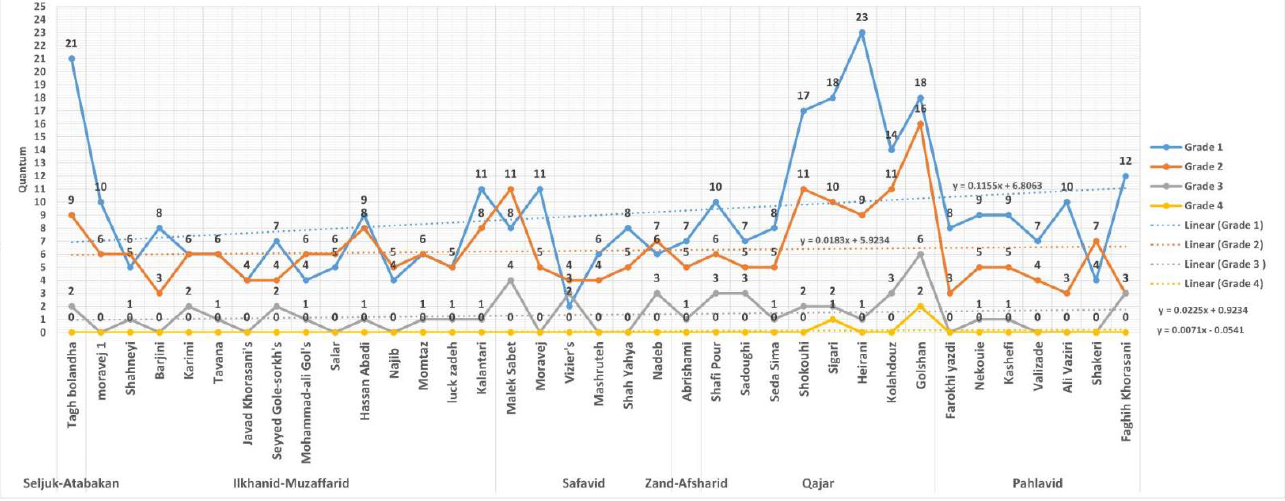
Figure 7. Number of gradient 1+ rooms ( K G1-4 ) and trendlines for the 37 houses, presented chronologically by era.